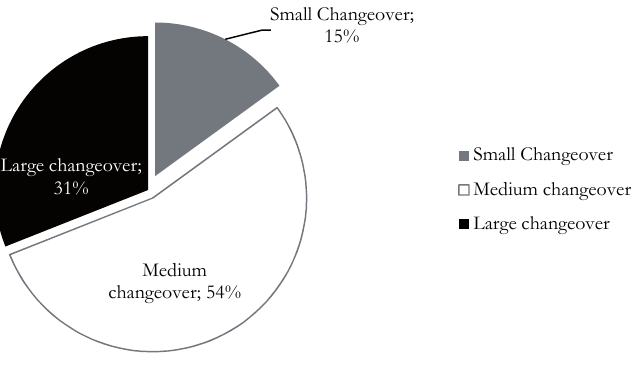
Fig. 4 – Changeover breakdown at the selected workplace (Filla,